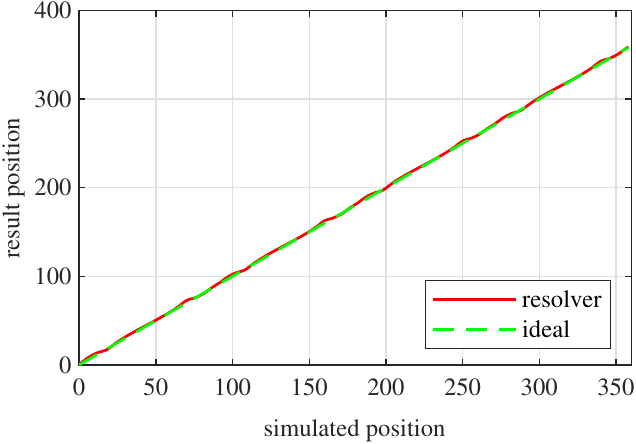
Figure 8. Full pitch four-slot skewed resolver position vs. the ideal position.